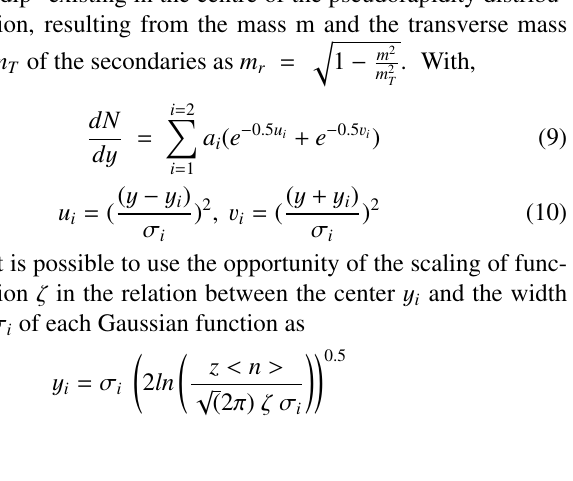
Figure 3. Inelastic data of CMS and Totem for 13TeV described using GHOST